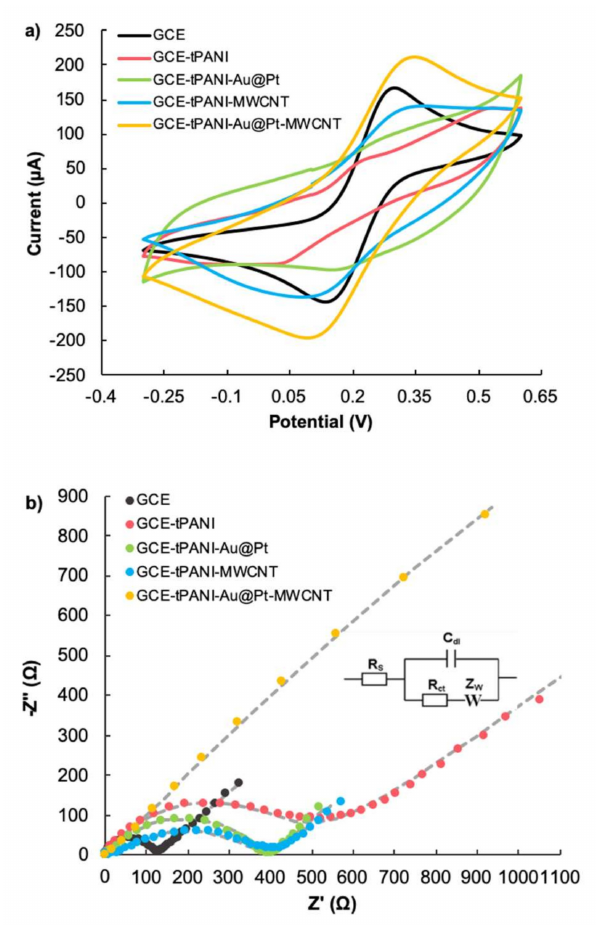
Figure 4. ( a ) Cyclic voltammograms, and ( b ) the Nyquist plots of GCEs with various modifications of nanocomposite components. Bare GCEs (black), GCE-tPANI (red), GCE-Au@Pt-tPANI (green), GCE-tPANI-MWCNT (blue), and GCE-tPANI-Au@Pt-MWCNT (yellow) in 10 mM Fe(CN) 63 − /4 − with 0.1 M NaClO 4 as supporting electrolyte. Following EIS studies, the resulting R CT values were extrapolated by fitting the Nyquist plots to a Randles equivalent circuit (shown in B , inset). Blank GCE demonstrated a charge transfer resistance (R CT ) of 135.35 ± 3.496 Ω